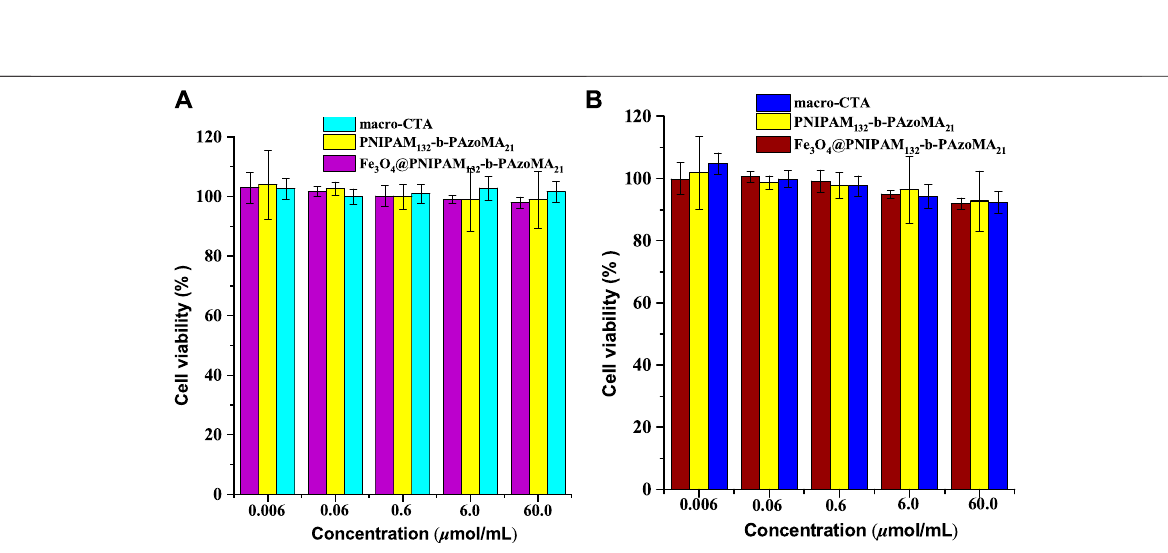
FIGURE 8 | Cell viability of (A) the L-929 cells and (B) the MCF-7 cells incubated with the samples (macro-CTA, PNIPAM-b-PAzoMA, and Fe 3 O 4 @PNIPAM-b- PAzoMA nanoparticles), over a range of sample concentrations from 0.006 to 60 μ mol/ml by MTT assay for 48